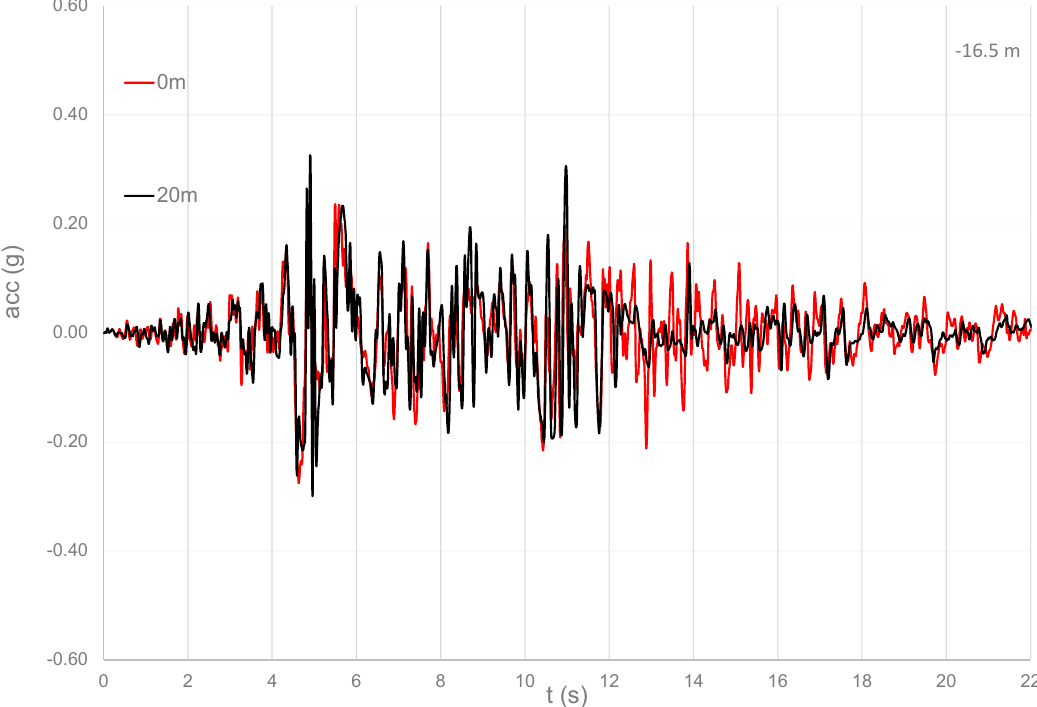
Figure 14. Acceleration time histories at − 16.5 m depth model-0 m and model-20 m.